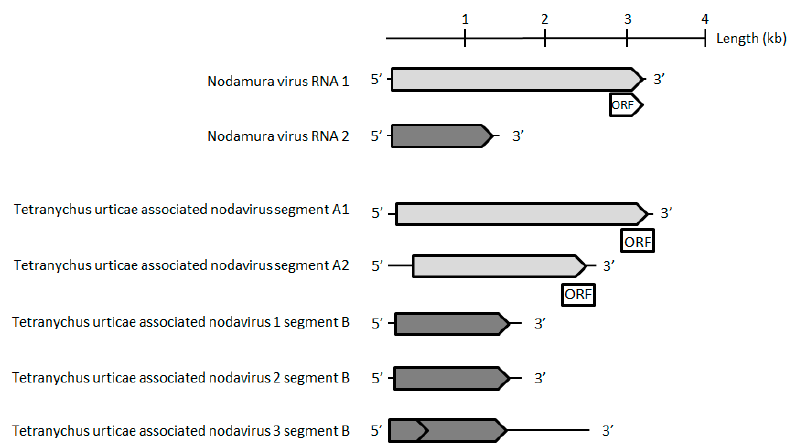
Figure 4. Maximum Nodaviridae likelihood phylogenetic tree based on part of the capsid protein, including 239 species and Tetranychus urticae-associated nodaviruses (in bold). The alignment of 229 amino acids in length was produced using MUSCLE 3.7 (16 iterations) and was ungapped by hand. The tree was mid-point rooted. Bootstrap values are indicated at each node. Scale bar corresponds to amino acid substitutions per site. Genomic organization of Tetranychus urticae-associated nodaviruses is also indicated. Grey arrows and rectangles: predicted open reading frames (ORF), Light grey: putative NS; dark grey: putative capsid protein (CP). Arrow: complete ORF; Rectangle: truncated ORF.